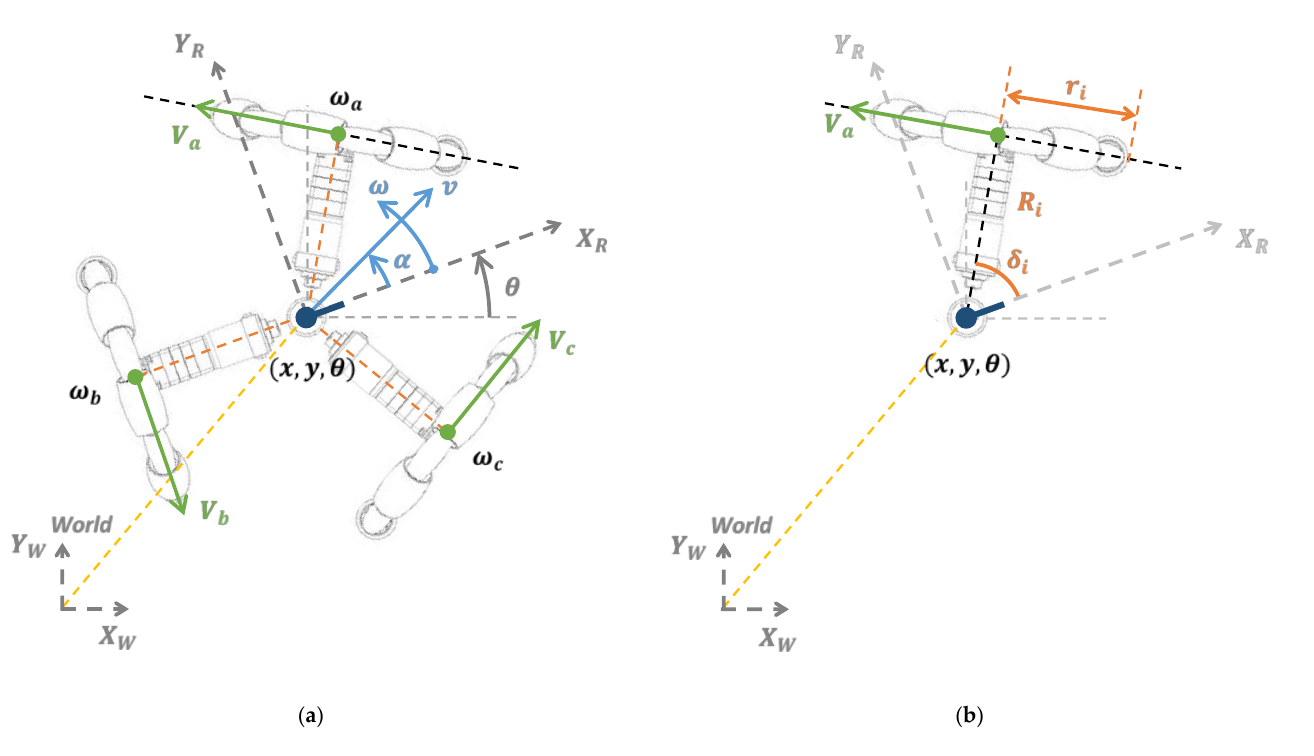
Figure 2. Parametric definition of the omnidirectional motion system of the mobile robot APR-02: ( a ) general representation of the three omnidirectional wheels and ( b ) detail of the parameters of one omnidirectional wheel. ( X R , Y R ) represents the mobile robot frame in which X R is the front of the mobile robot.